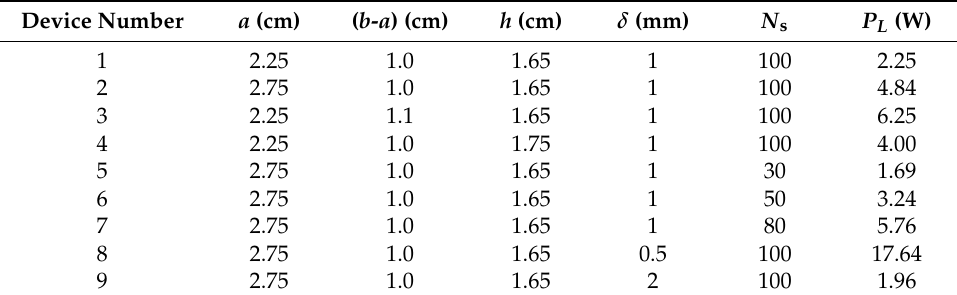
Table 1. Comparative experimental parameters of nine energy harvesting devices ( I 1 = 102.5 A, R L = 0.5 Ω